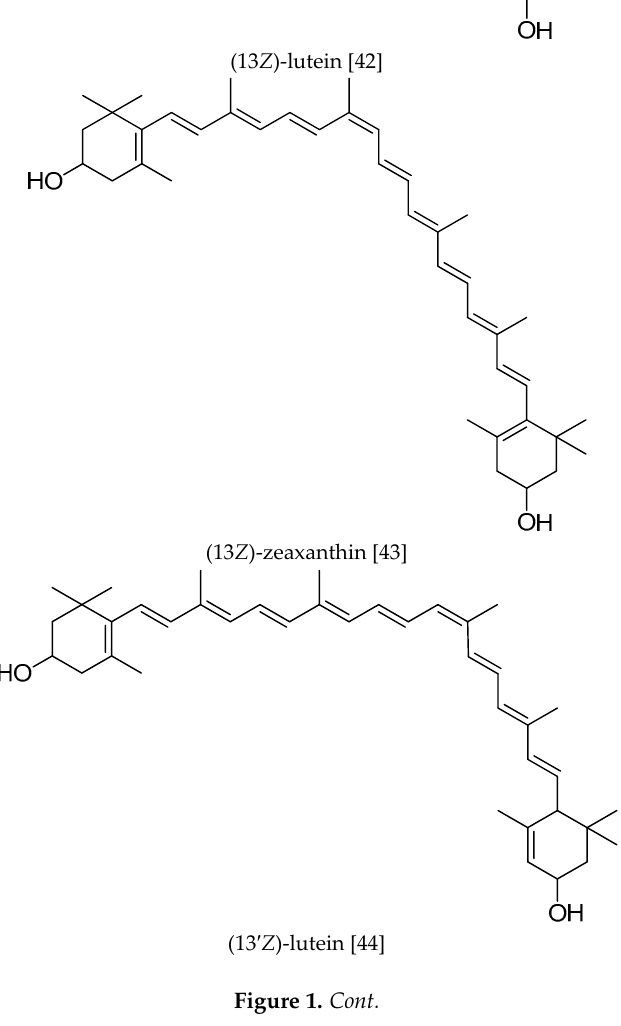
Figure 1. Cont . Figure 1.